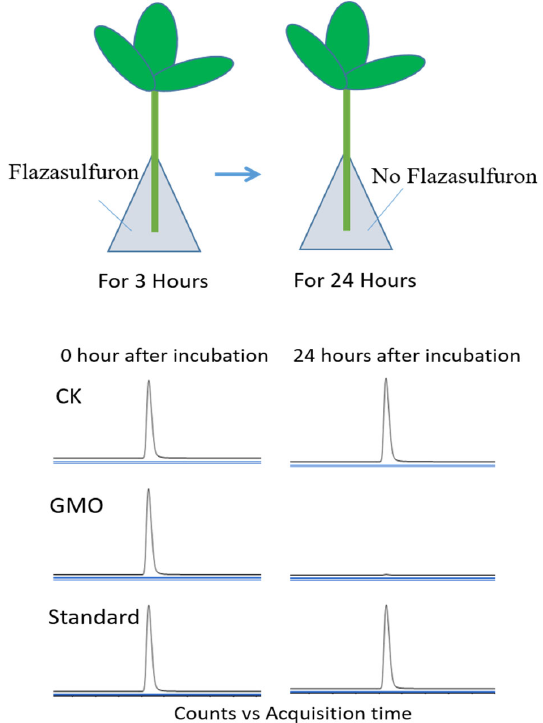
Figure 5. Flazasulfuron was rapidly degraded by transgenic soybean expressing P450-N-Z1. Upper panel: diagram showing that the soybean leaves were cut to be cultured with solution containing flazasulfuron for 3 h, and then with solution containing no flazasulfuron for 24 h. Lower panel: the flazasulfuron in the leaves was detected by HPLC chromatograms at 0 h and 24 h after herbicide incubation. CK, non-transgenic soybean as control; GMO, transgenic soybean; Standard, chemical standard of flazasulfuron.